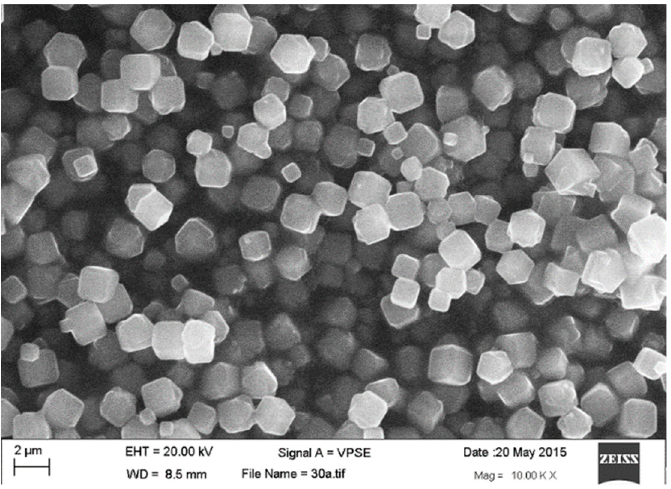
Figure 2. Scanning electron micrograph obtained for the synthesized zeolite Y.